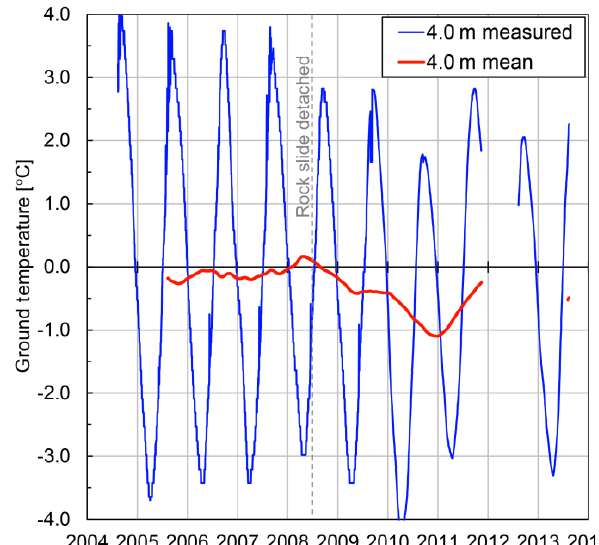
Figure 12. Ground temperature time-series at 4m depth from a nearby permafrost borehole (Guolasjávri (Gu-B-1), 786ma.s.l.; more details can be found in Farbrot et al., 2013). The blue line shows the measured daily values and the red line shows a simple moving 365-days average, i.e. the unweighted mean of the previous 365 days. The grey dotted line indicates the detachment date of the Signaldalen rock